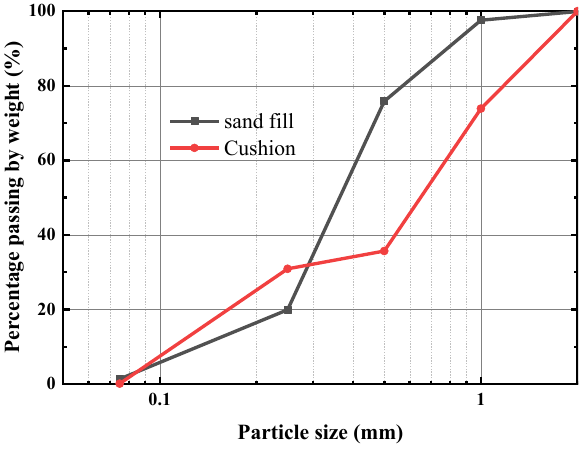
Figure 3: Particle size distribution of cushion and model foundation